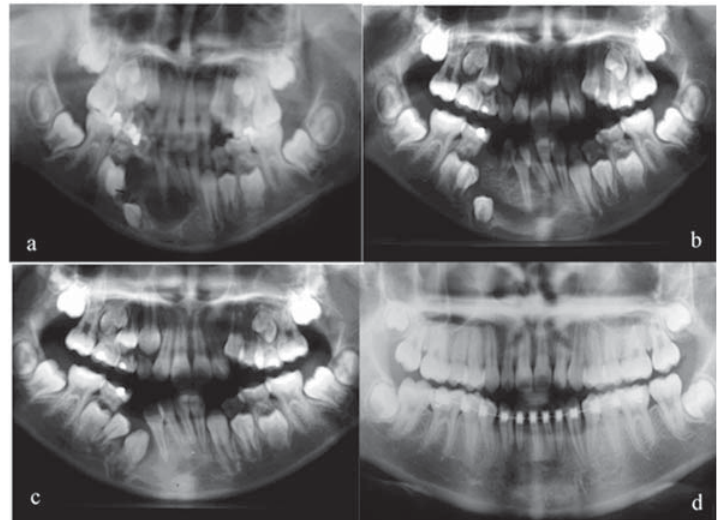
Figure 3- Panel of panoramic radiographs. (a) Segmented osteolytic lesion in the right mandible body presenting a (cid:16)(cid:8)(cid:17)(cid:18)(cid:19)(cid:10)(cid:9)(cid:6)(cid:8)(cid:11)(cid:20)(cid:10)(cid:19)(cid:21)(cid:18)(cid:19)(cid:11)(cid:3)(cid:5)(cid:21)(cid:11)(cid:6)(cid:5)(cid:8)(cid:17)(cid:22)(cid:16)(cid:6)(cid:10)(cid:5)(cid:11)(cid:3)(cid:5)(cid:21)(cid:11)(cid:21)(cid:6)(cid:16)(cid:23)(cid:17)(cid:3)(cid:8)(cid:18)(cid:2)(cid:18)(cid:5)(cid:9)(cid:11)(cid:10)(cid:24)(cid:11)(cid:23)(cid:18)(cid:19)(cid:2)(cid:3)(cid:5)(cid:18)(cid:5)(cid:9)(cid:11)(cid:8)(cid:3)(cid:5)(cid:6)(cid:5)(cid:18)(cid:25)(cid:11)(cid:7)(cid:19)(cid:16)(cid:9)(cid:11)(cid:3)(cid:5)(cid:21)(cid:11)(cid:16)(cid:18)(cid:8)(cid:10)(cid:5)(cid:21)(cid:11)(cid:23)(cid:19)(cid:18)(cid:2)(cid:10)(cid:17)(cid:3)(cid:19)(cid:16)(cid:26)(cid:11)(cid:27)(cid:20)(cid:15)(cid:11)(cid:28)(cid:29)(cid:19)(cid:18)(cid:18)(cid:30)(cid:2)(cid:10)(cid:5)(cid:9)(cid:29)(cid:11)(cid:24)(cid:10)(cid:17)(cid:17)(cid:10)(cid:31)(cid:30) up image showing that permanent teeth went to natural eruption and decompression was maintained by iodoform gauze. (c) Two-year follow-up image showing permanent teeth in spontaneous eruption. (d) Seven-year follow-up image showing complete osteogenesis and teeth eruption